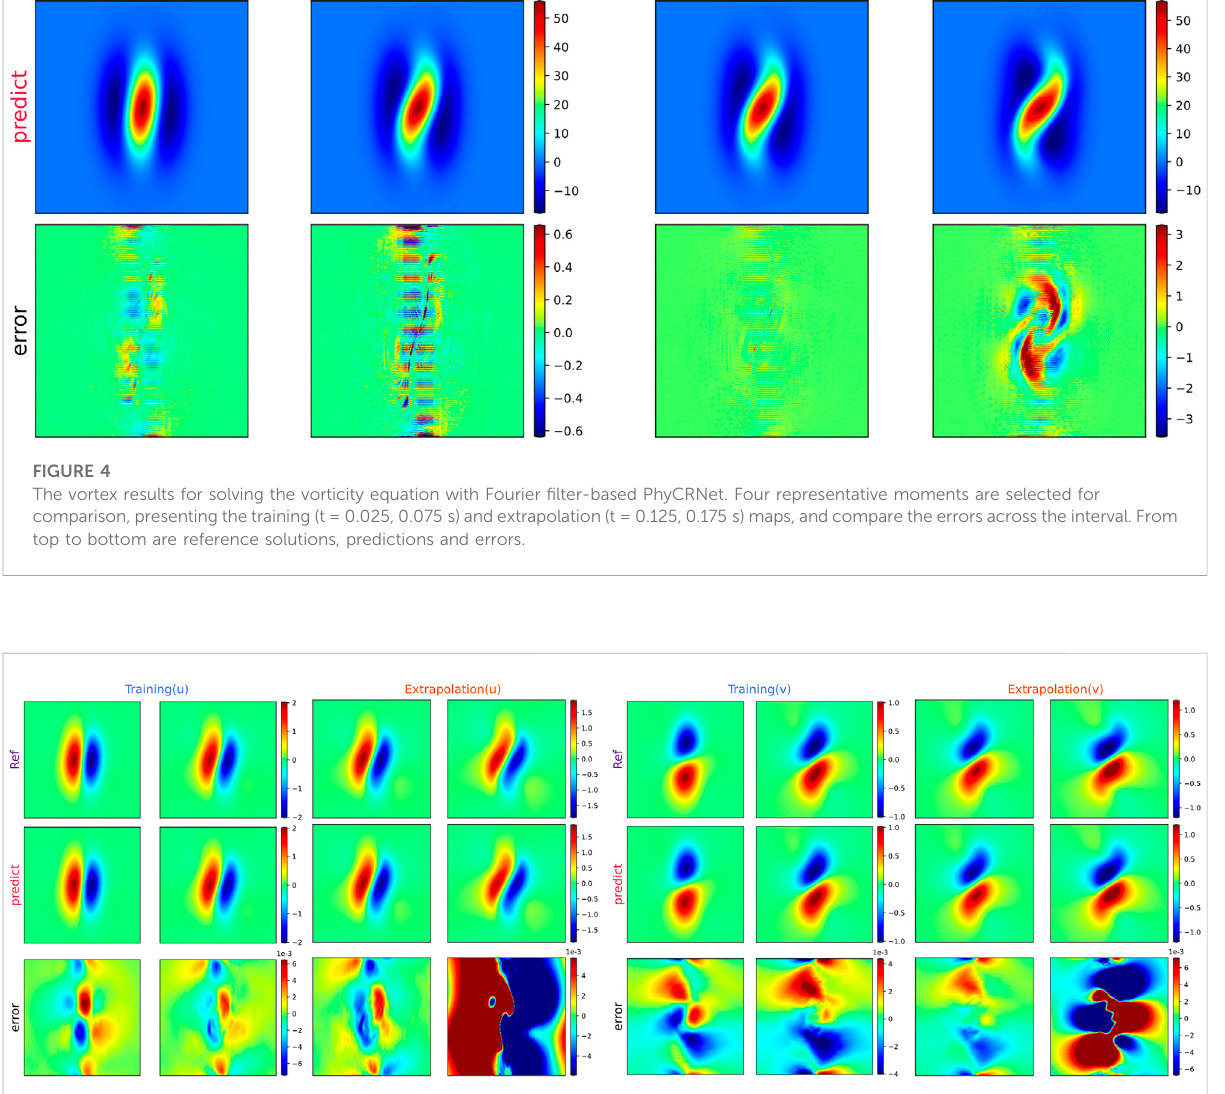
period increases, the error also increases. However, when the extrapolation is at the same training time, the shape of the rotation is still the same. In the region with a larger value, the